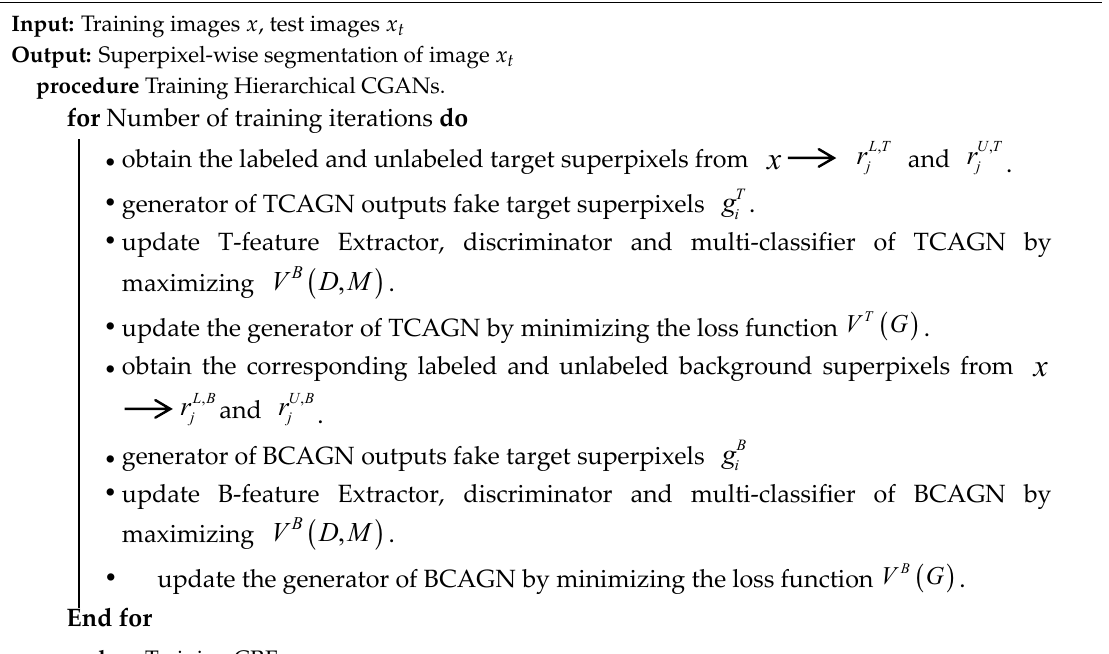
Algorithm 1 : Hierarchical Adversarial CRF (HACRF) based Image Algorithm 1: Hierarchical Adversarial CRF (HACRF) based Image Segmentation